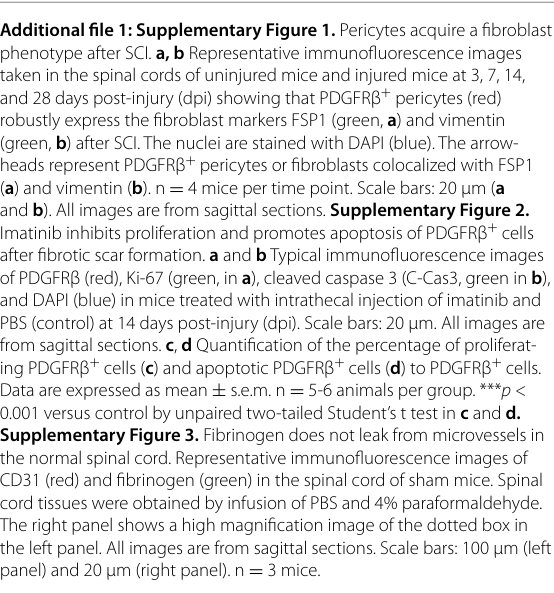
Supplementary Figure 3. Fibrinogen does not leak from microvessels in the normal spinal cord. Representative immunofluorescence images of CD31 (red) and fibrinogen (green) in the spinal cord of sham mice. Spinal cord tissues were obtained by infusion of PBS and 4% paraformaldehyde. The right panel shows a high magnification image of the dotted box in the left panel. All images are from sagittal sections. Scale bars: 100 μm (left panel) and 20 μm (right panel). n 3 =